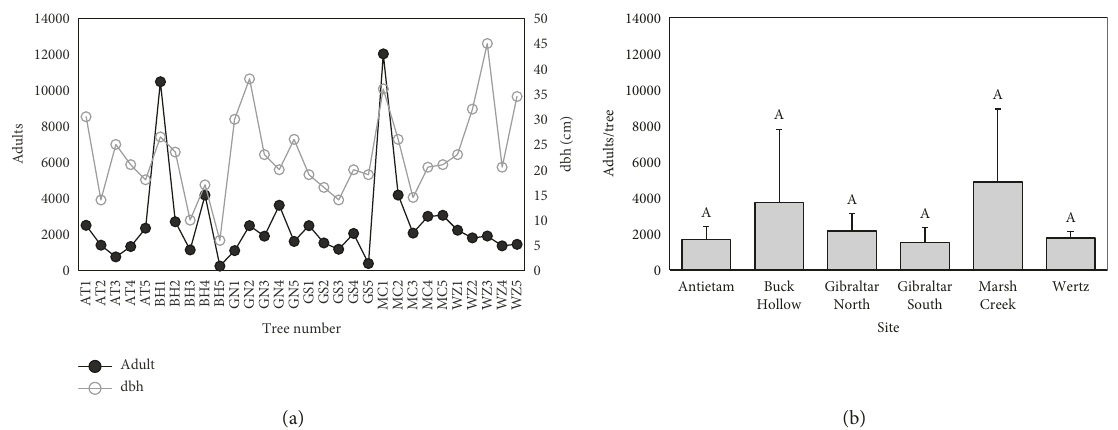
Figure 2: Lycorma delicatula adult count (a) total by tree and (b) average (mean ± SD) by site. AT: Antietam, BH: Buck Hollow, GN: Gibraltar North, GS: Gibraltar South, MC: Marsh Creek, WZ: Wertz. Means in (b) followed by the same uppercase letter are not significantly different ( α �